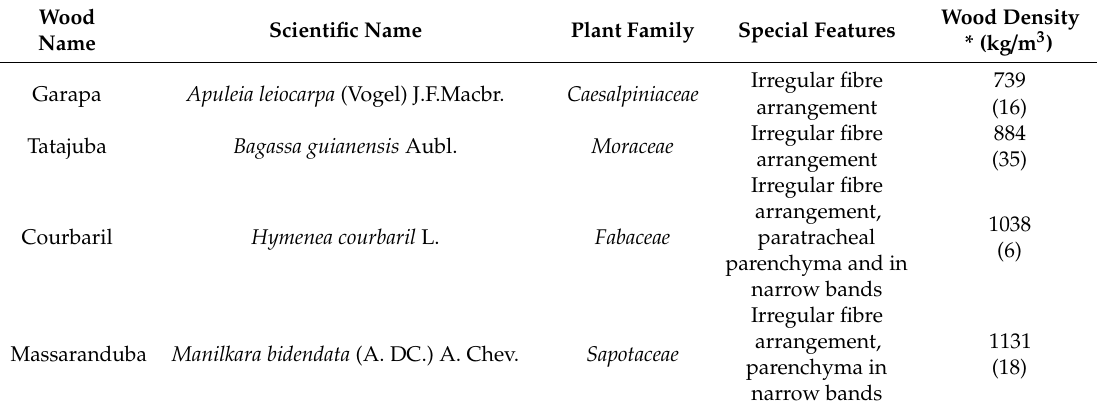
Table 1. Wood species used in